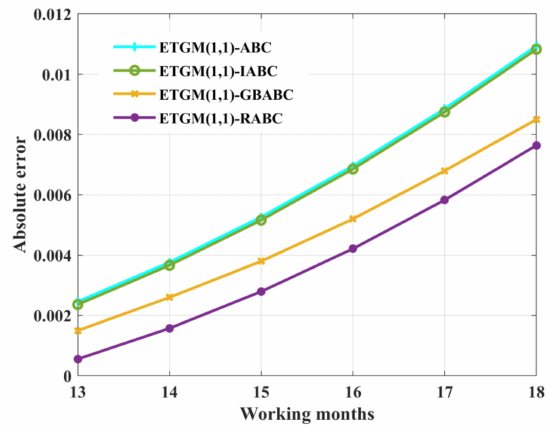
Figure 10. Absolute error curve. Table 5. The predicted results obtained by four